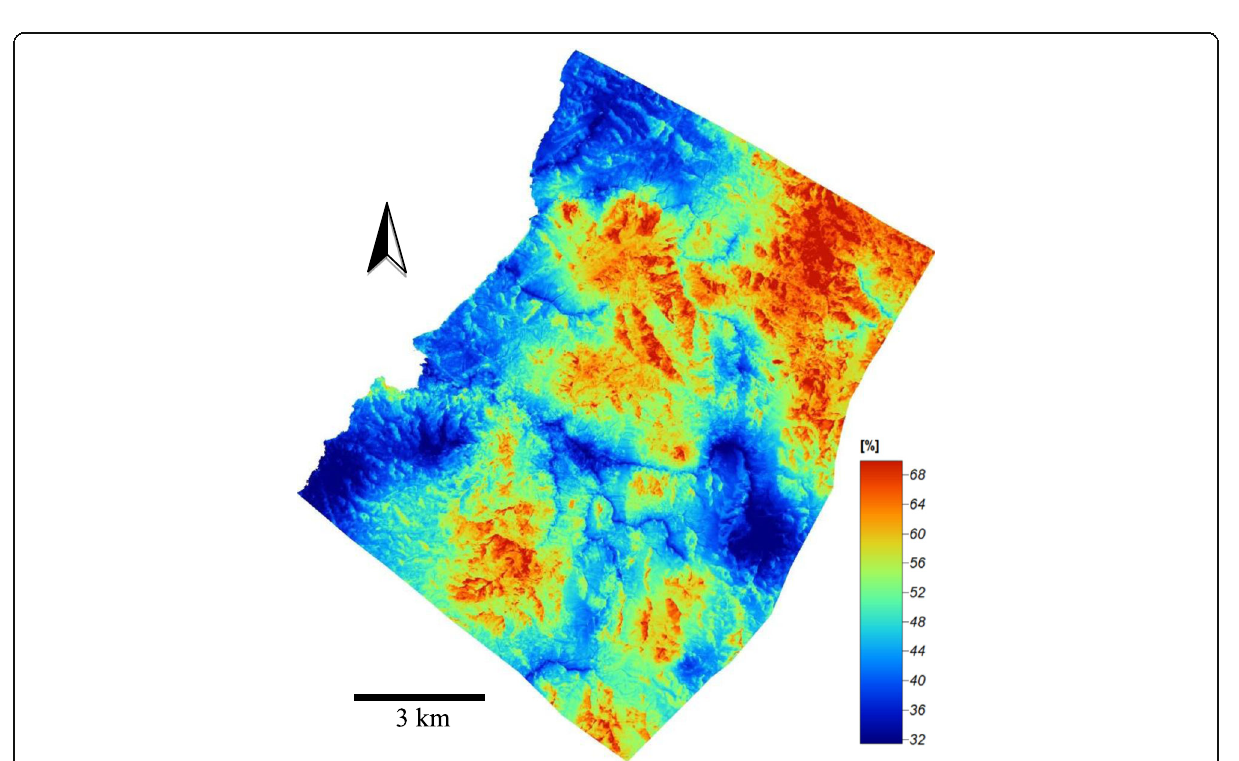
Fig. 8 Final Model of Clay after back